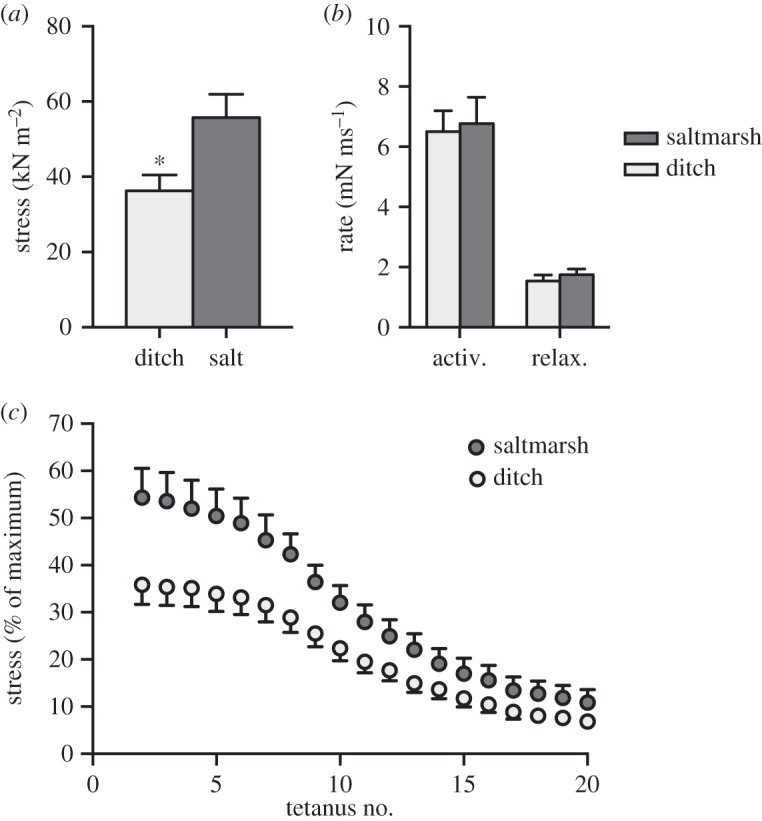
Mechanics of isolated muscle of fish from the ditch and the saltmarsh habitats. Muscle of fish from the ditch habitat produced significantly less stress (force/cross-sectional area) than muscle of saltmarsh fish (indicated by asterisk; (a), but there were no differences in the activation and relaxation rates of muscle between the different habitats (b). Muscle stress produced relative to maximum for each muscle preparation was greater and declined less rapidly in saltmarsh fish (c). Means ± s.e. are shown, n = 8 fish per habitat.